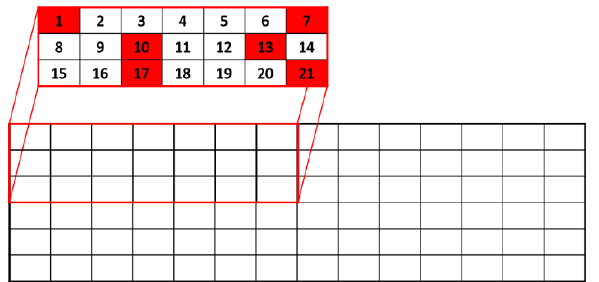
Figure 1. Sketch of the cross-section of the as-cast bar (width 1.5 m and height 0.45 m), indicating the location of the samples studied with SAXS and SANS within one-quarter of the cross-section (sample numbers from #1 to #21). The six samples highlighted with red color were additionally investigated with SEM and TEM.